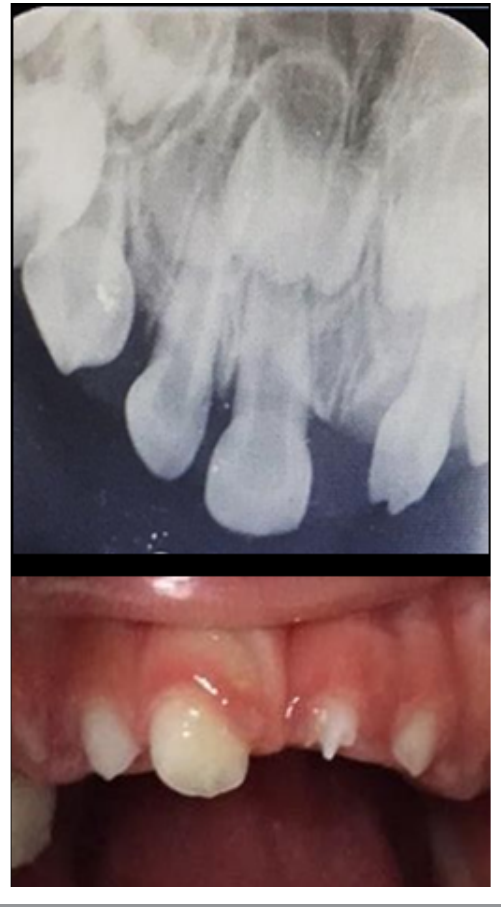
Figure 4. Dental anomalies of shape in tooth